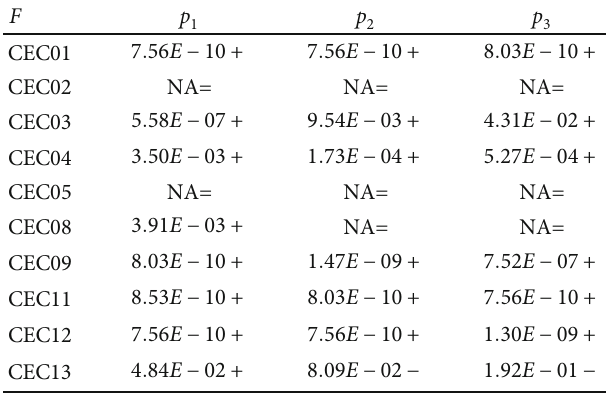
Table 12: Rank sum test value under